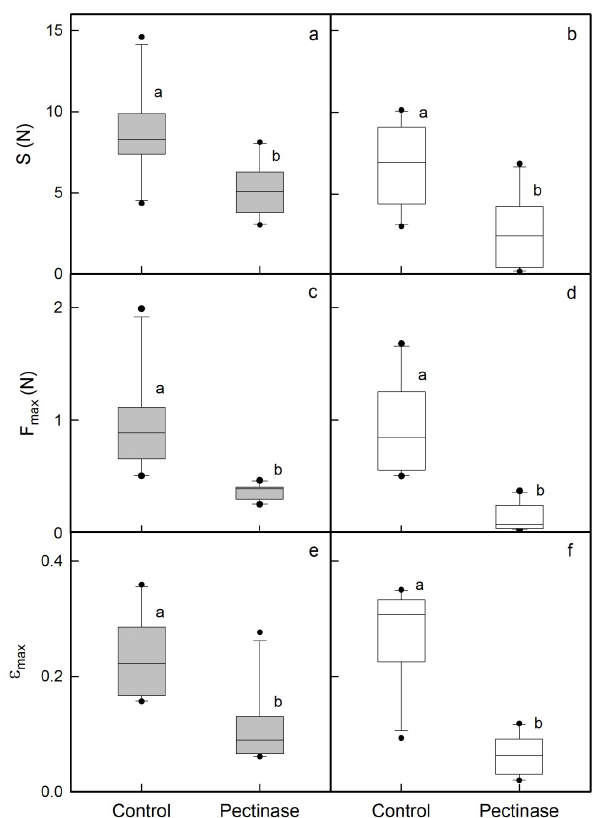
Fig. 9: Effect of pectinase treatment on stiffness (S) (a, b), maximum force (F max ) (c, d) and maximum strain ( ε max ) (e, f) of internodes (a, c, e) and nodes (b, d, f) of Chara corallina . Pooled data for positions 2 and 3. Means of controls and treatments are significantly different, P <